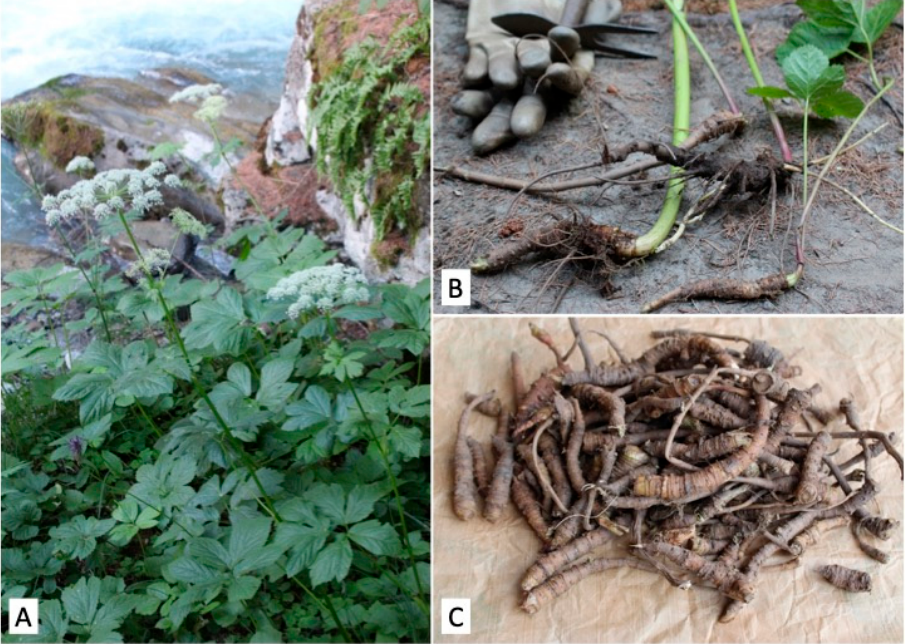
Figure 1. ( A ) Plants of P. ostruthium in their natural environment. ( B ) Freshly sampled rhizomes. ( C ) Clean rhizomes used for micromorphological analysis and extract preparation.